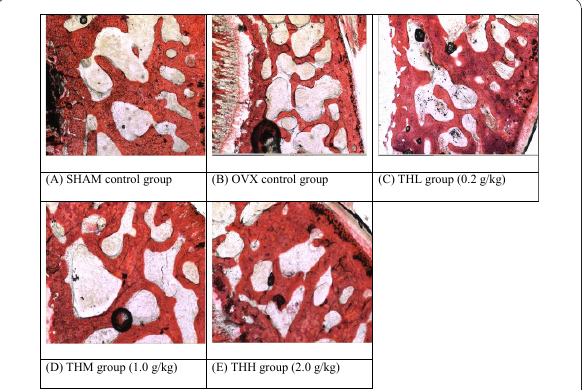
Figure 1 Effects of Tualang honey on uterine morphology in rats . OVX control group showed an atrophic uterus with cuboidal endometrial epithelium, endometrium with cuboidal inactive cells and stroma in less cellular. After 2 weeks administration of Tualang honey at all doses has resulted in a partially reversal of uterine atrophy. The increased thickness of endometrium in all treated groups was due to an increased in the amount of collagen in the stroma. All pictures are stained with H&E and examined under ×20 magnification: SHAM = Sham-operated control rats, OVX = ovariectomised non-honey treated control rats, THL = Tualang